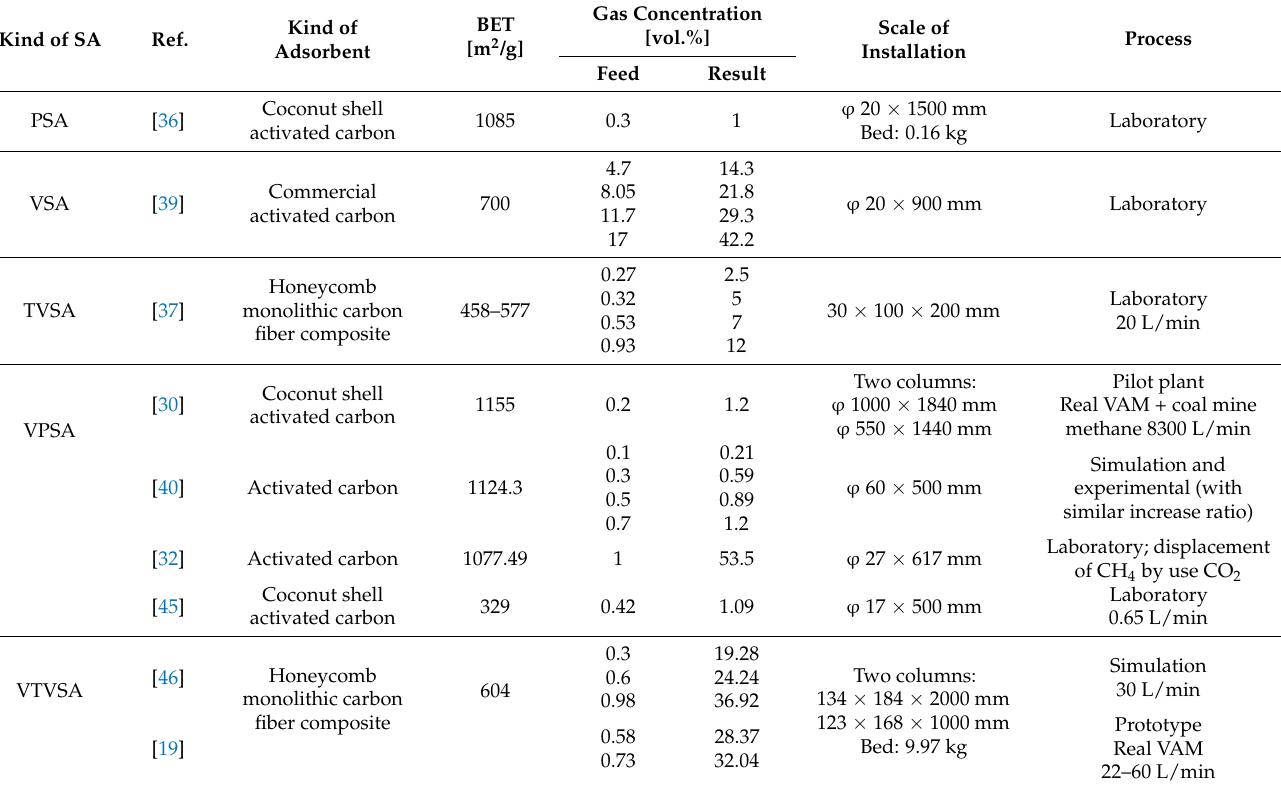
Table 2. The chosen data for adsorption with solid sorbents for VAM enrichment. Kind of SA